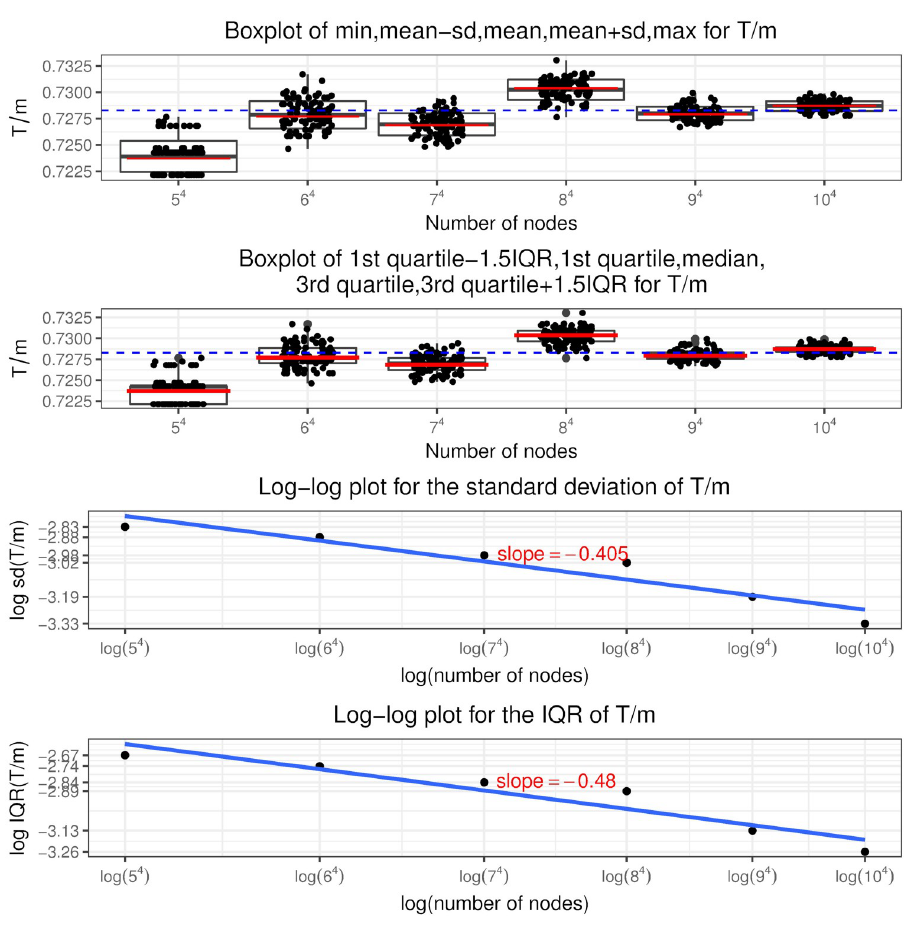
Fig 8. The boxplot and log-log plot of standard deviation and IQR for T / m under optimal policy.